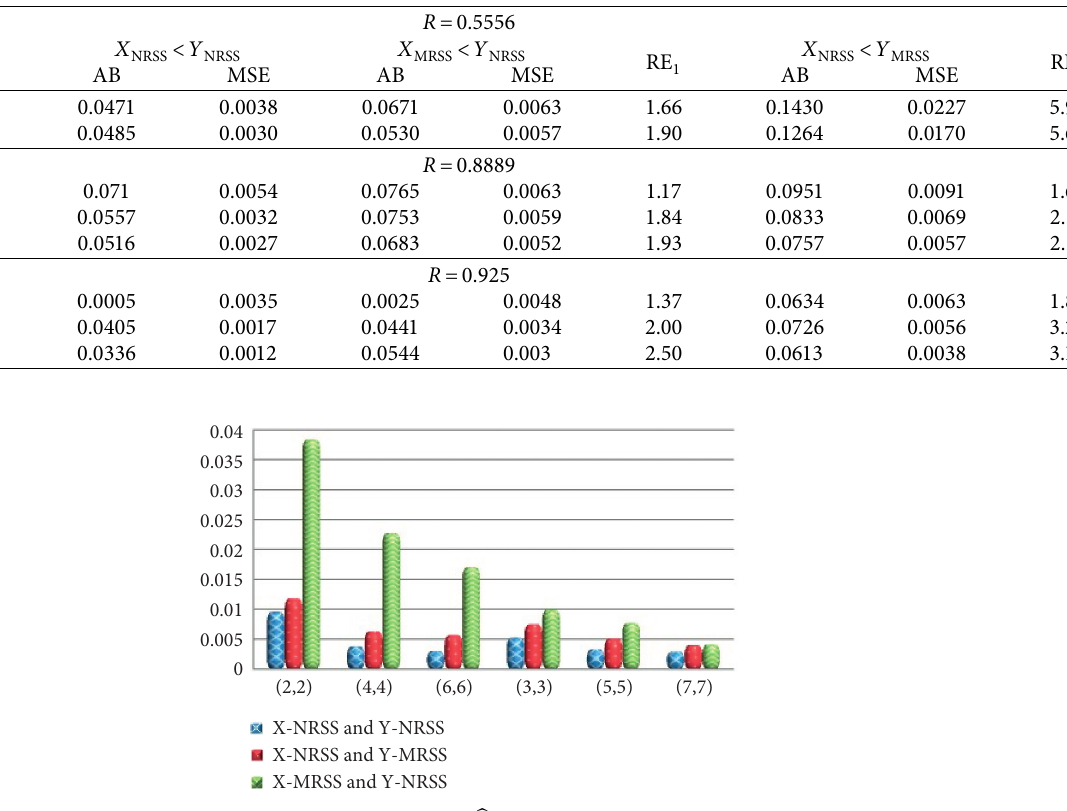
Figure 1: MSE of 􏽢 R at ( R ) �